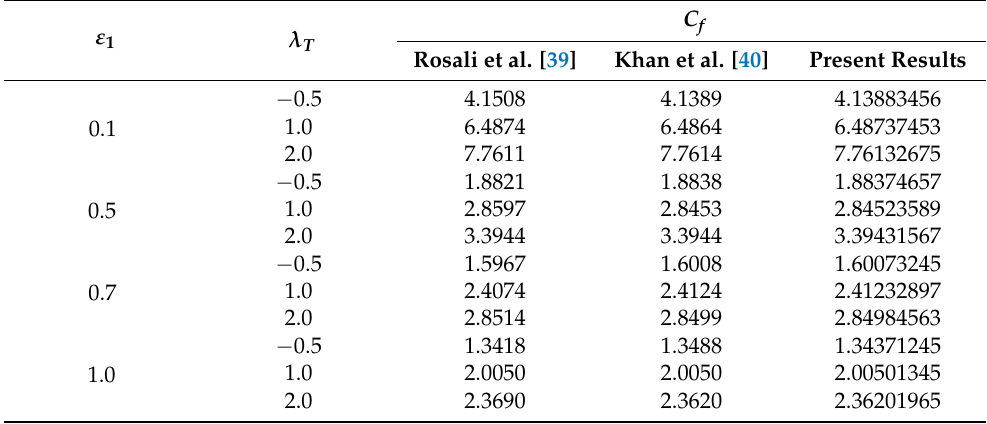
Table 1. Validations of C f for varying values of ε 1 and λ T when K 1 = 1.0 and the rest of the controlling parameters are